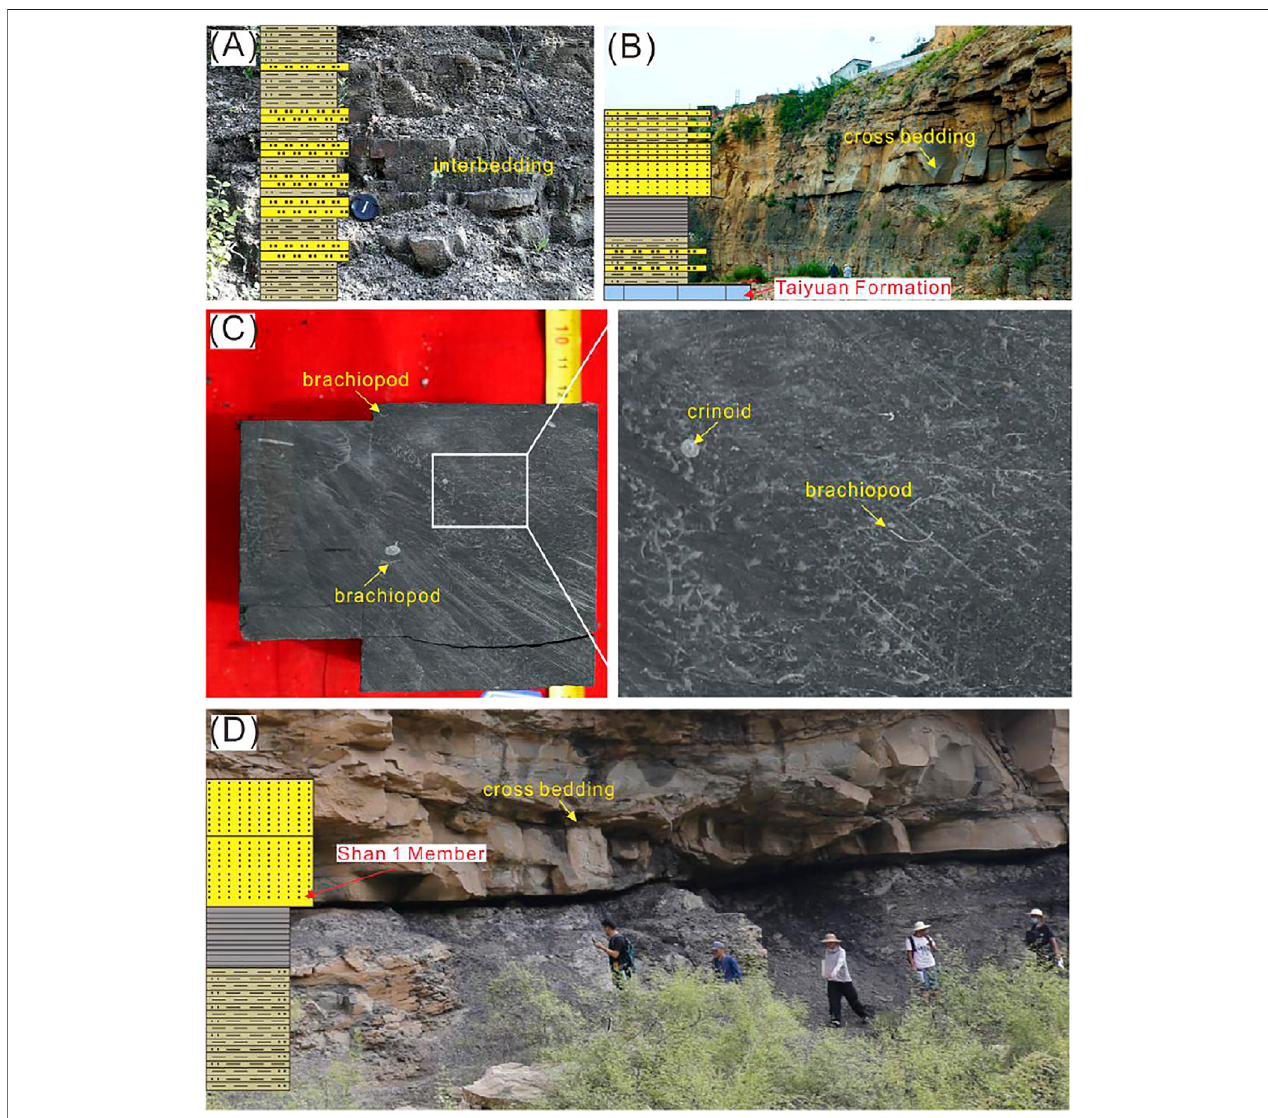
FIGURE3 | Sedimentarycharacteristics forShanxi Formation Shan 2 3 Submember shalefrom outcrops inthe Eastern Ordos Basin. (A) Frequent thin interbedsof siltstone and silty mudstone, Shan 2 3 -1 section, Taitou Outcrop. (B) Medium-grained sandstone with cross-bedding, Shan 2 3 -1 and Shan 2 3 -2 sections, Chengjiazhuang Outcrop. (C) Organic-rich shale containing abundant marine bioclasts including crinoid and brachiopod, Shan 2 3 -1 section, 2,294.89 m, studied well. (D) Shan 2 3 -4 section, Chengjiazhuang Outcrop.